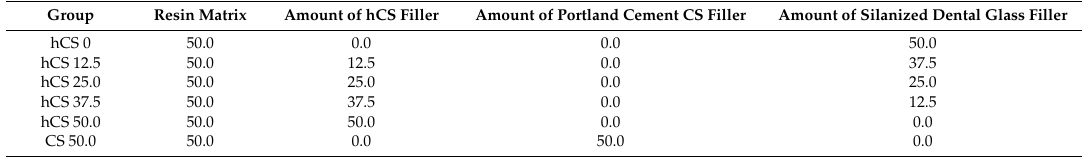
Table 1. Weight ratio of the filler proportions in each group